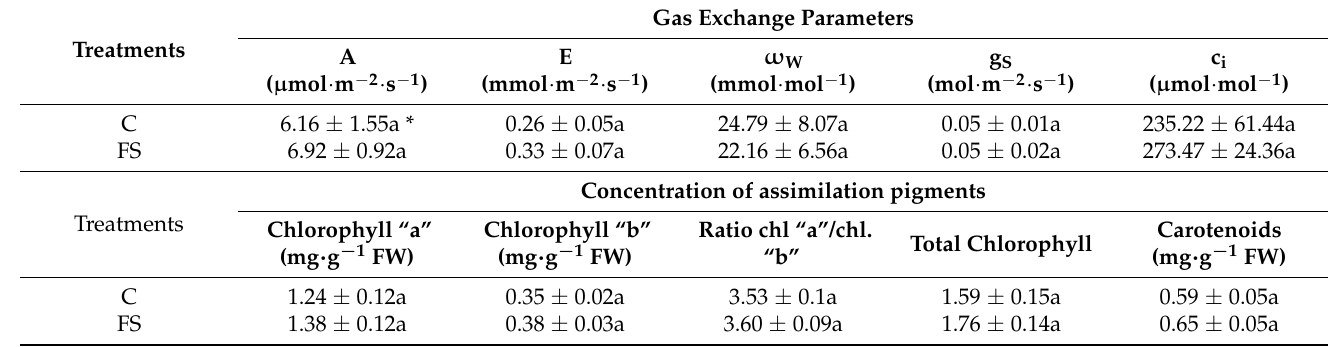
Table 3. Effect of fertilisation on the intensity of CO 2 assimilation (A) and transpiration (E),